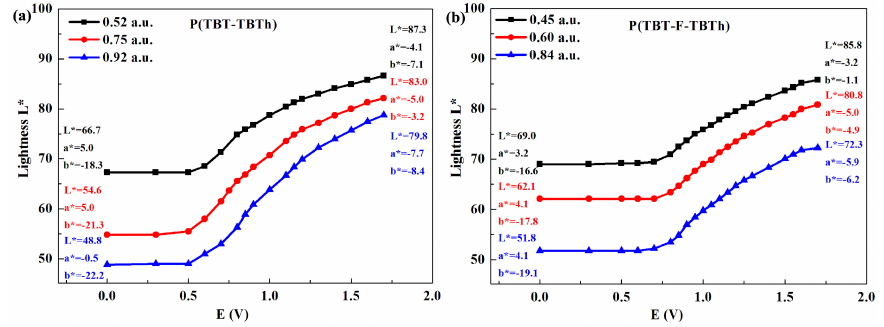
Figure 10. Plot of lightness of the polymer films as a function of applied potential: (a) P(TBT-TBTh); (b) P(TBT-F-TBTh).